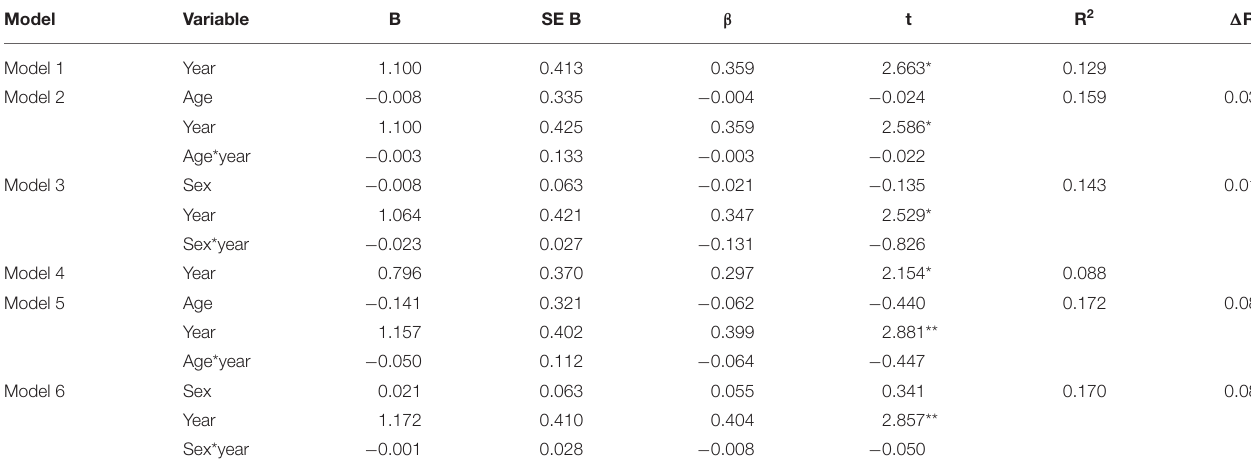
TABLE 3 | Regression results of CSE scores and year of data